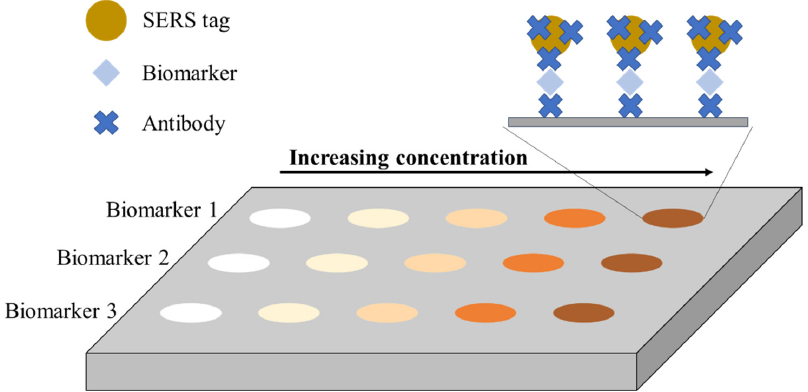
Figure 6. Schematic representation of lab-on-a-chip platform combined with SERS for biomarker detection based on antigen–antibody interactions (based on [69]).